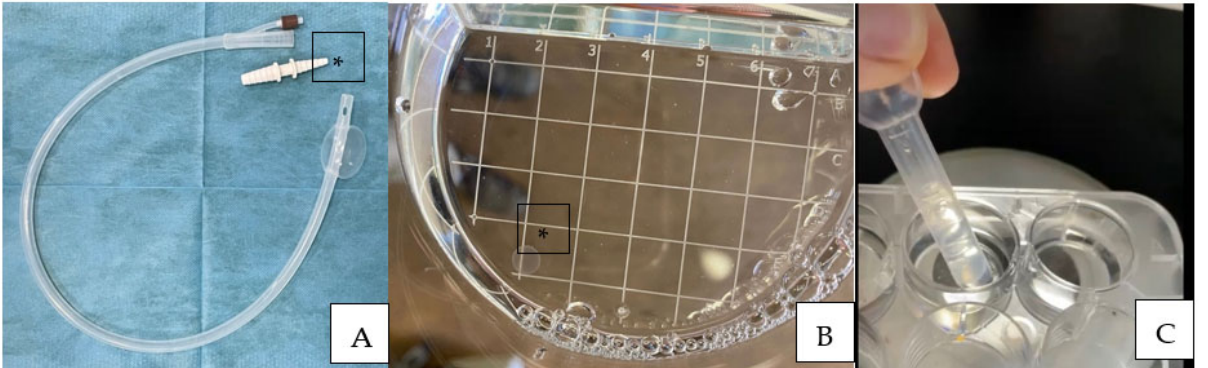
Figure 1. One-way 36 Fr silicon cuffed catheter used for uterine flushing for embryo recovery ( A ). Note that the plastic fitting [*] was removed after RL irrigation to recover the fluid without damaging the embryo. ( B ) EZ-Way Filter without the lid, [*] note one of the recovered embryos. ( C ) Modified 3 mL plastic Pasteur pipette for embryo manipulation.